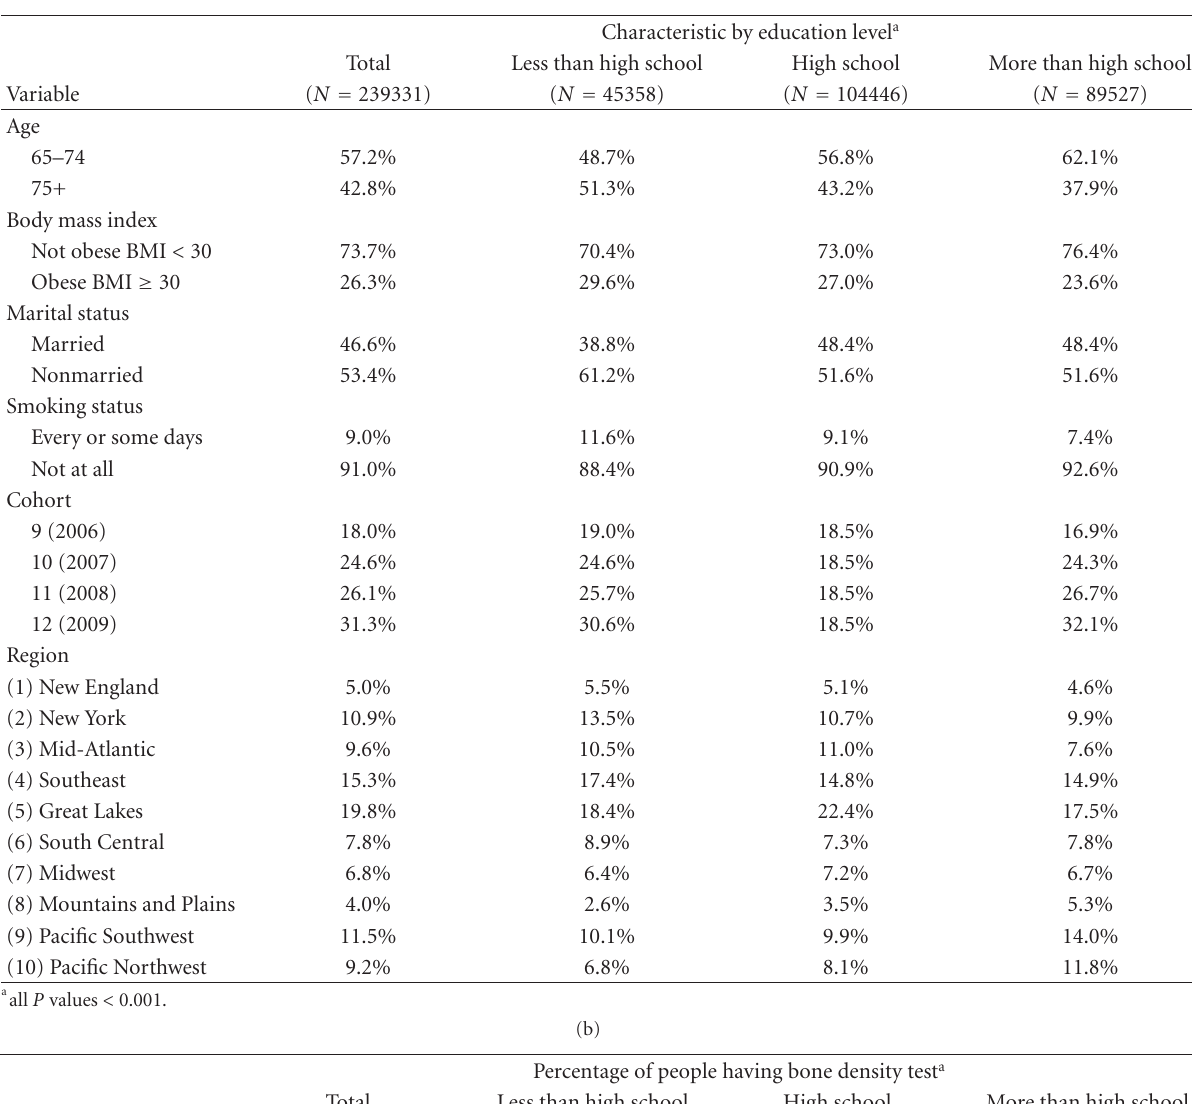
Table 1: (a) Descriptive statistics by education level and logistic regression analysis. (b) percentage of bone density test and logistic regression